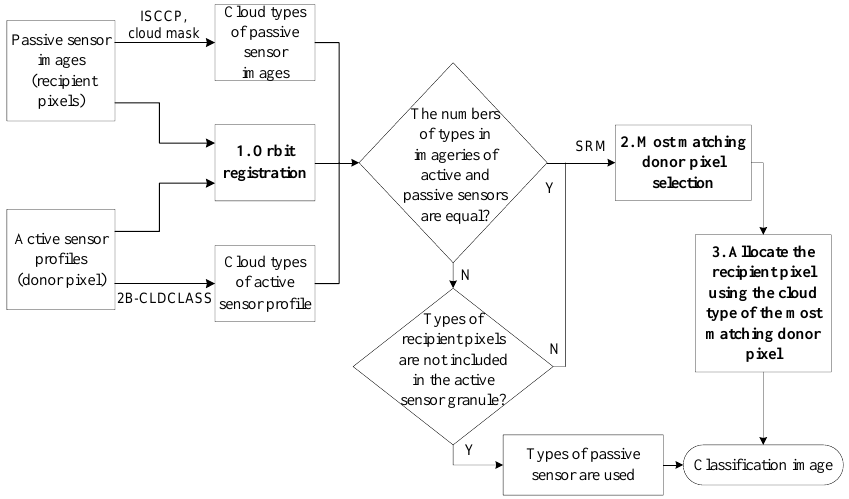
Figure 5. Flow chart of cloud classification based on similar radiance matching (SRM).